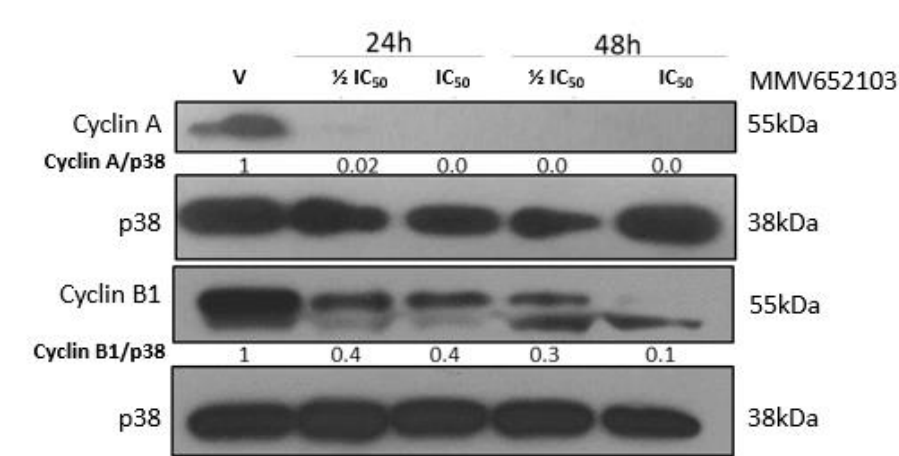
Figure 5: MMV652103 induces a sub-G1 peak and G1 cell cycle arrest in MCF7 breast cancer cells. ( A ) Representative cell cycle profiles of MCF7 cells exposed to vehicle or IC 50 MMV652103 for 24 and 48 h as determined by staining cells with propidium iodide and measuring their DNA content by flow cytometry. The table shows the proportion of cells at each phase of the cell cycle expressed as a percentage of the total number of cells analyzed ± SEM pooled from three independent experiments. ( B ) Western blot analyses of protein harvested from cells treated as indicated and incubated with antibodies against cell cycle markers cyclin A and cyclin B1 and p38 was used as a loading control. Densitometry readings were obtained using ImageJ and protein expression levels are represented as a ratio of protein of interest/p38 normalized to the vehicle control sample. Blots are representative of at least three independent